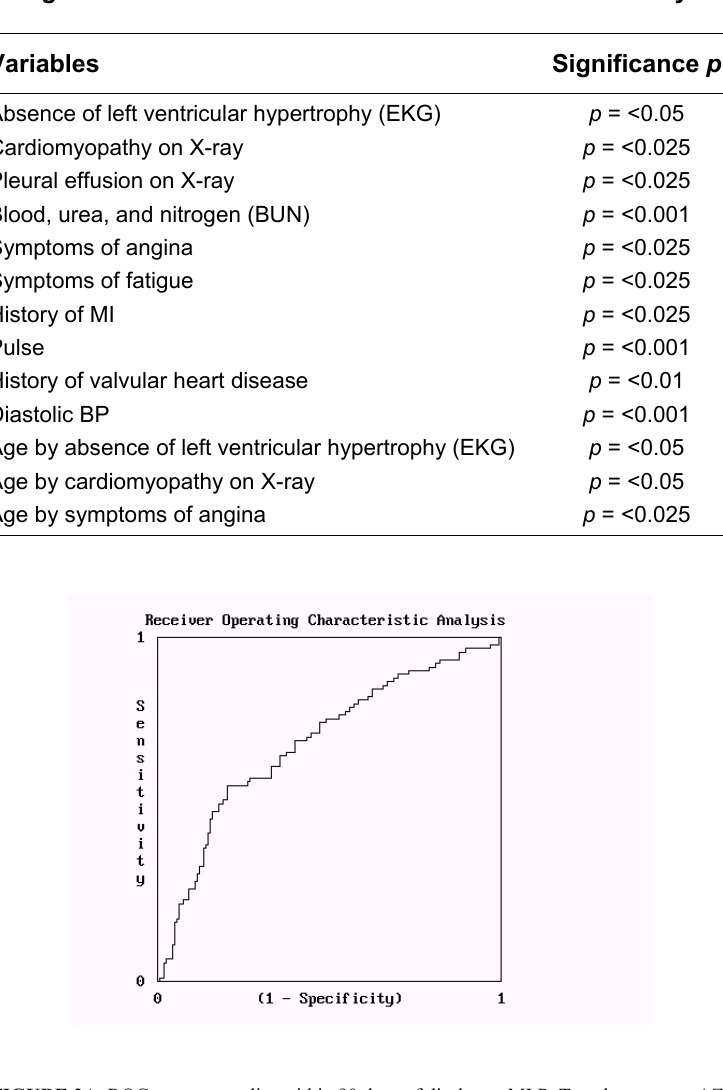
FIGURE 3A. ROC curve mortality within 90 days of discharge MLP. Test data: _____ AZ: